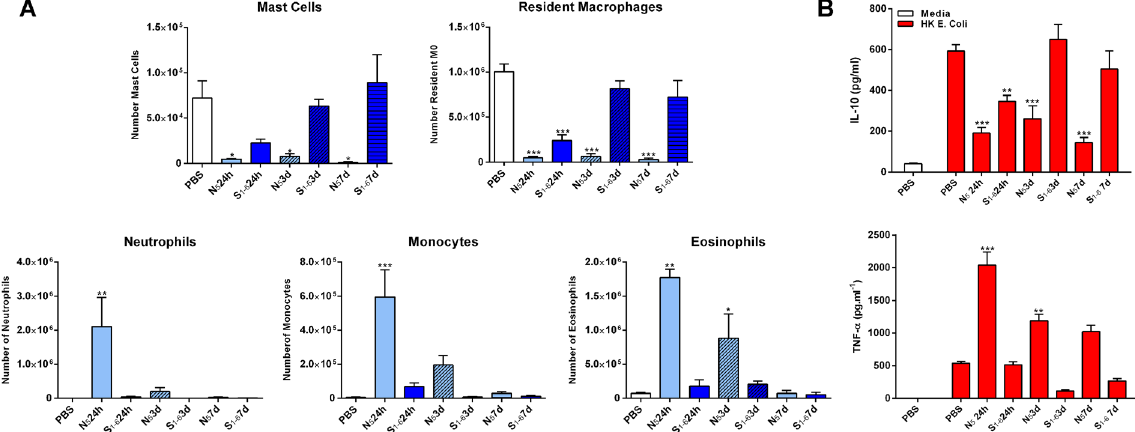
Figure 6. Injection of needle-shaped HA particles modulates cell recruitment in vivo . Female C57BL/6 mice (n = 3) aged 6–8 weeks were injected intraperitoneally with PBS vehicle, N 5 (1 mg/mouse) or S 20 1–6 µ m (1 mg/mouse) HA particles. Twenty-four hours, three days and seven days later peritoneal lavage cells were collected. ( A ) PECS were stained to analyse cell recruitment by flow cytometry. Cells were characterized using a combination of markers for peritoneal resident macrophages (CD11b hi F4/80 hi MHCII − ), mast cells (SiglecF − cKit + ) monocytes (CD11b + SiglecF − F4/80 − Gr1int SSC low ), neutrophils (CD11b + SiglecF − F4/80 − Gr1 hi ) and eosinophils (CD11b + SiglecF + Gr1 − SSC hi ). Data are expressed as number of single/live cells. ( * p < 0.05, ** p < 0.01, *** p < 0.001). ( B ) PECs were restimulated with complete RPMI 1640 medium or